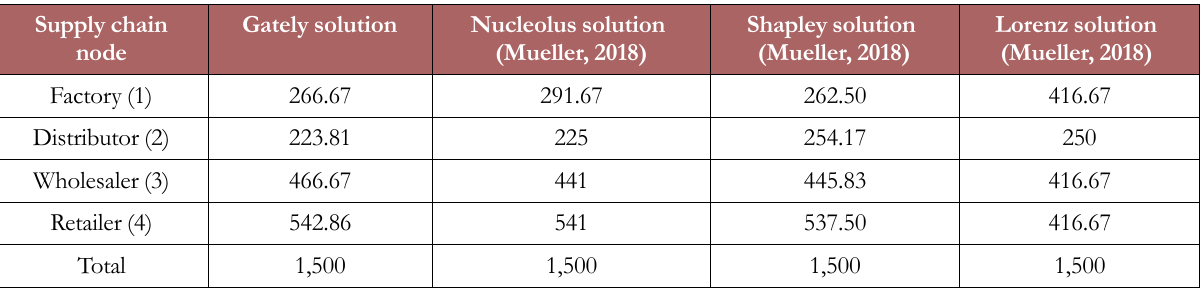
Table 2. Profit allocation according to the various game-theoretic mechanisms